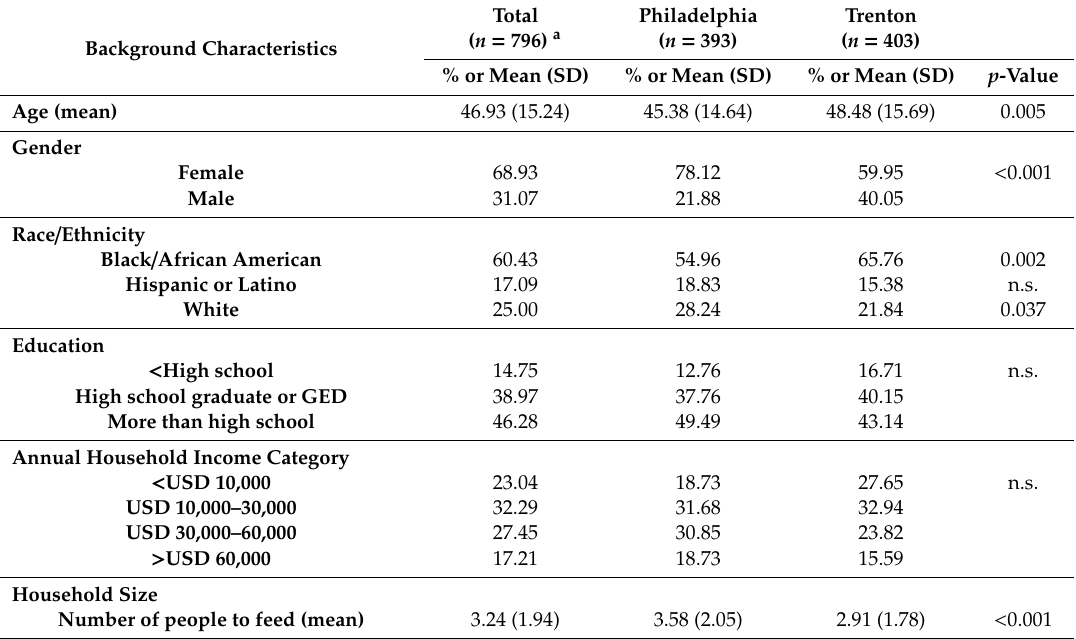
Table 3. Background Characteristics of Study Participants by Food Desert